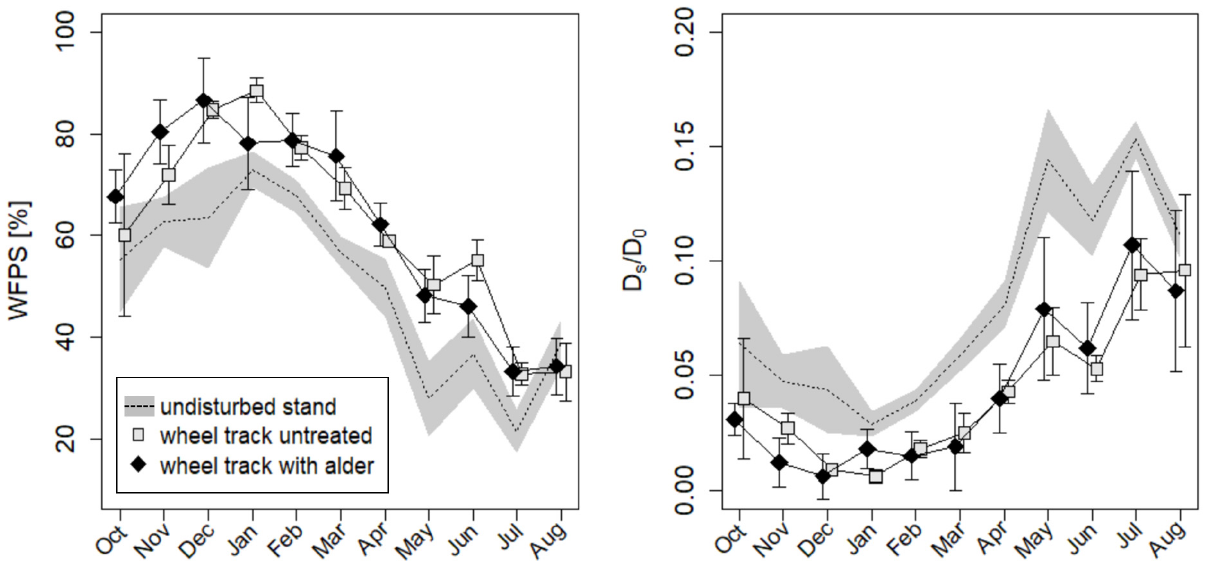
Figure 4. Monthly median values of WFPS ( left ) and modeled relative diffusion coefficient ( right ) in the undisturbed beech stand (dashed line) and on wheel tracks 10 years after soil trafficking (2017/18). The grey shading and error bars indicate the 95% confidence intervals of median values.